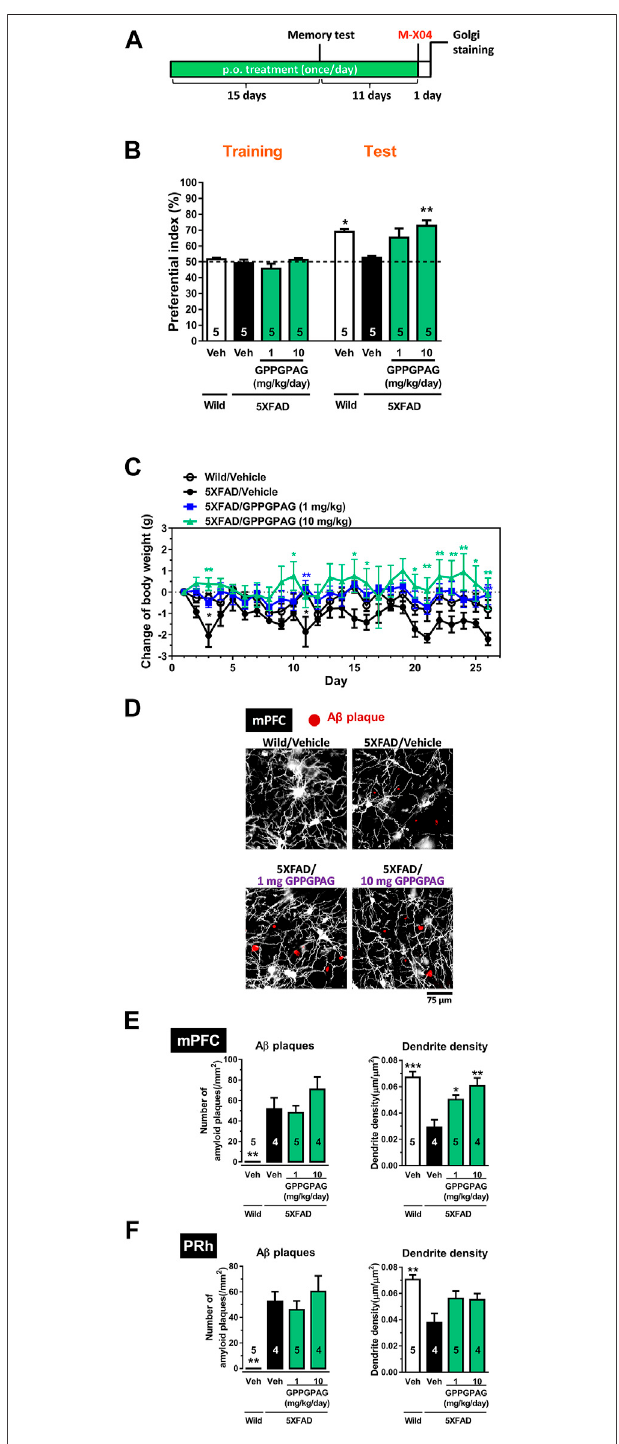
FIGURE 3 | Effect of oral administration of GPPGPAG on object recognition memory de fi cit and dendritic atrophy in 5XFAD mice (A) GPPGPAG (1 and 10 mg/kg/day, p. o.) or a vehicle solution (physiological saline) was administered for 15 days to mice (male, 5 – 6 months